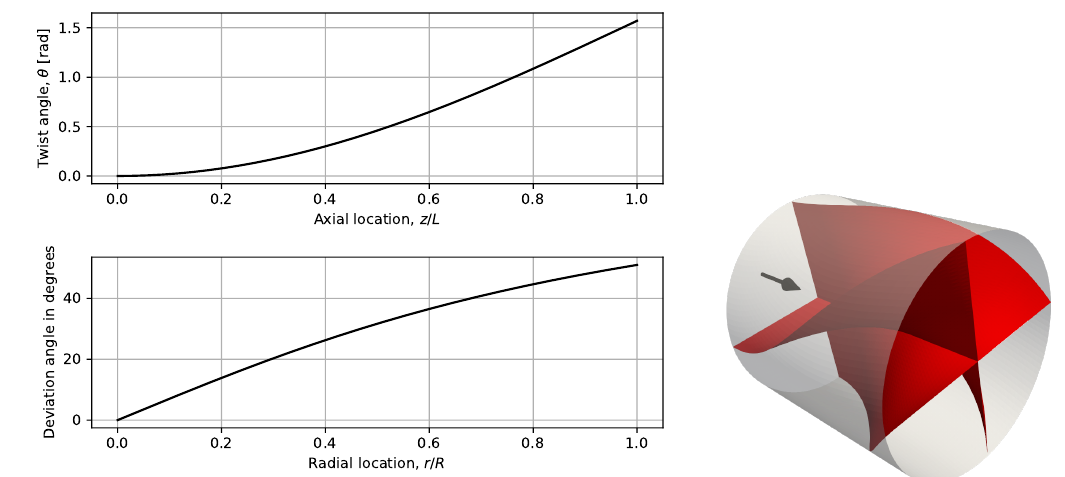
Figure 6. Case I, with four blades and twist angle not affected by radius. ( upper left ) twist angle as a function of axial location; ( lower left ) deviation angle as a function of radial location; ( right ) the blade set up in the pipe. Note that the arrow shows the direction of the flow in front of the